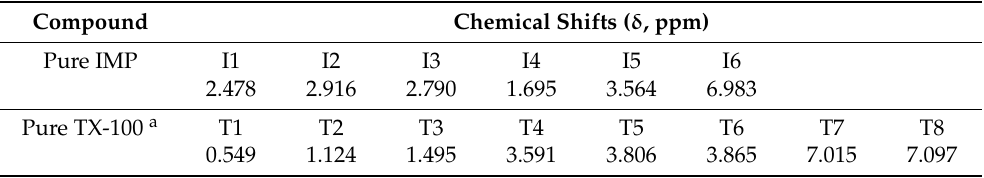
Table 3. 1 H NMR chemical shifts ( δ , ppm) of pure IMP and TX-100 in aqueous